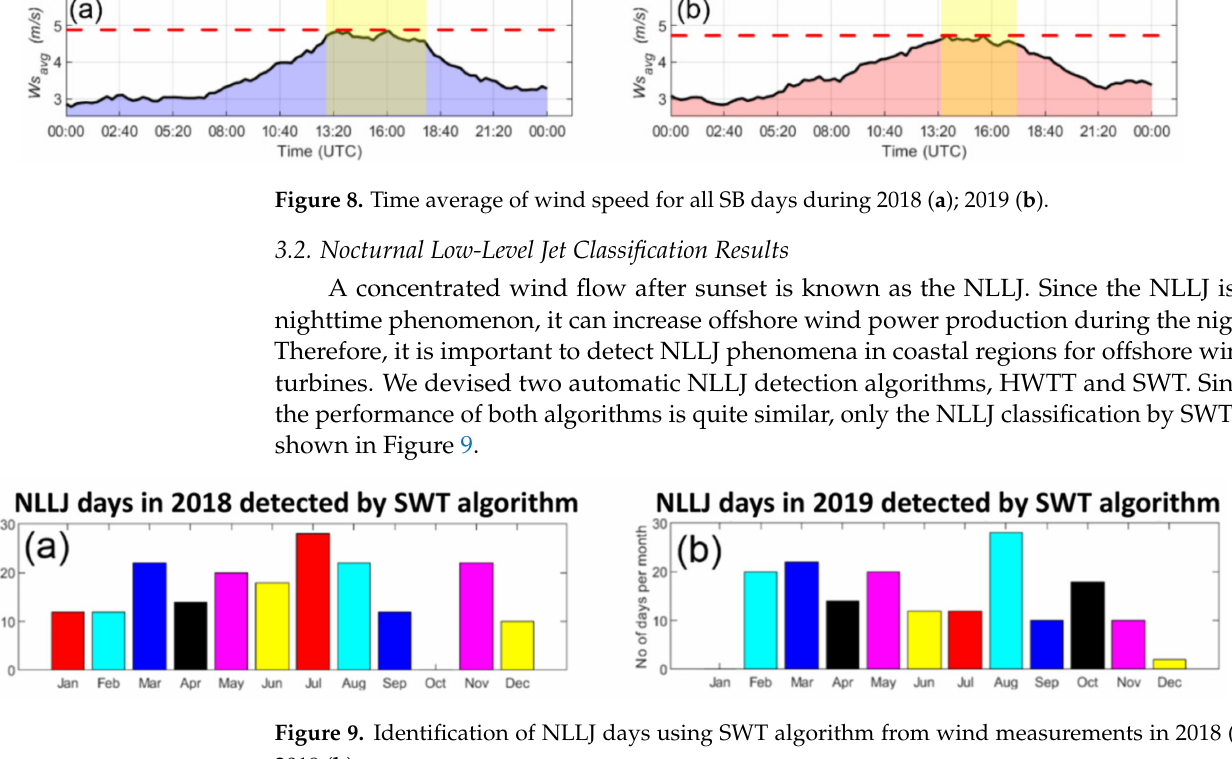
Figure 9. Identification of NLLJ days using SWT algorithm from wind measurements in 2018 ( a ); 2019 ( b